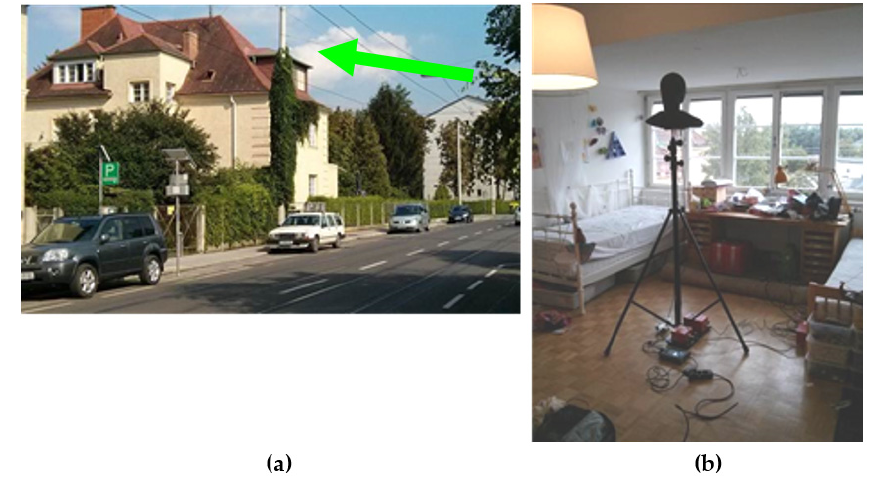
Figure 2. Measuring Point 3, single house, 2nd floor: ( a ) outside view facing tramway rails; and ( b ) measurement setup in the children’s